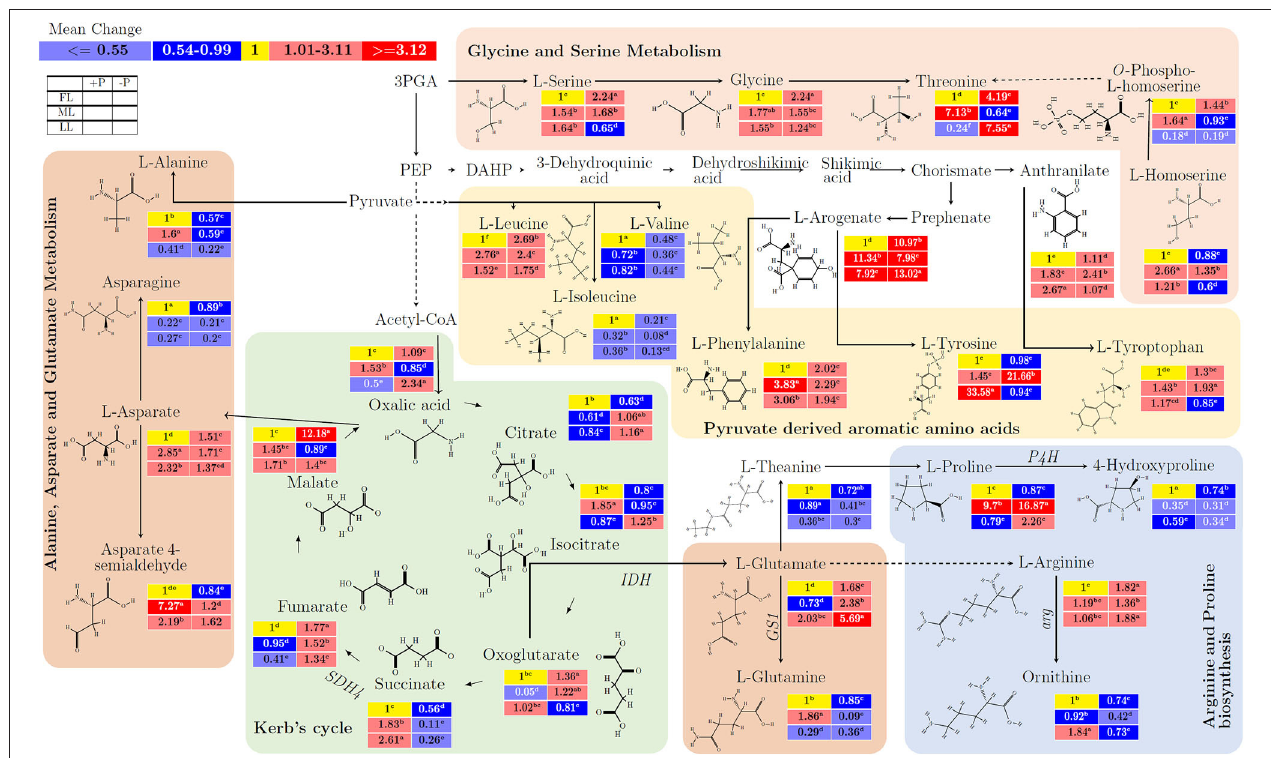
FIGURE 3 | The interactive effect of light and P on the biosynthesis of amino acids and/or related anaplerotic pathway metabolites in young shoots of Fengqing cultivar measured by GC × GC–TOF/MS. The mean of each metabolite followed by a different letter in the heatmap table indicates a significant change in light and P treatments. In the heatmap, red boxes represent the value > 1 and are separated into dark red and mild red by the mean value of the figured pathway data ( > 1) and subsequently < 1 with blue and mean value separated into mild blue and dark blue from figured pathway data ( < 1). The yellow box represents the normalization value. The blank table in the legend shows the position of the mean P and light treatment value of the